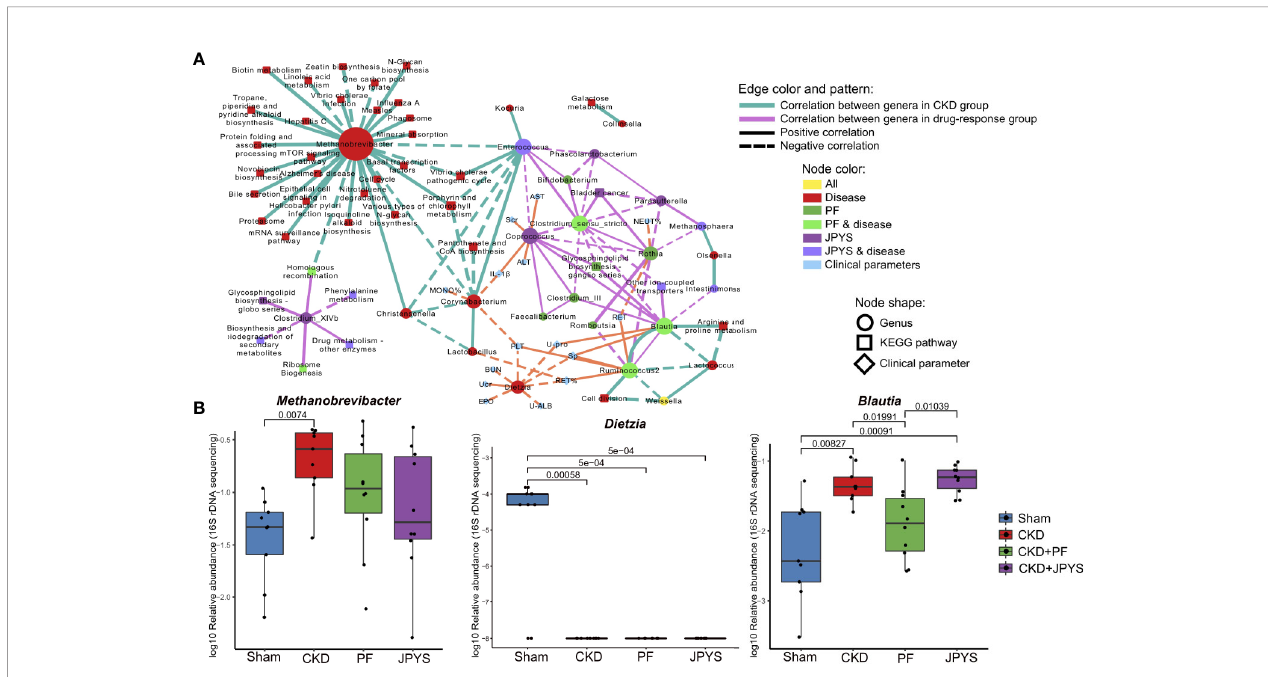
FIGURE 3 | Gut microbiome markers correlated with host clinical outcomes. (A) Correlation network of microbiome marker, clinical parameter, and KEGG pathway. Circles represent markers of genus; Squares represent KEGG pathways; and diamonds represent clinical parameters. Node colors indicate treatment groups. Node sizes are scaled according to their degrees of connections. The larger the node is, the more connections it has. Two nodes are connected if their spearman correlation is signi fi cant ( p < 0.05, FDR-corrected) between genera, or between genera and KEGG pathways. Connections are drawn between genera and clinical parameters only when their spearman correlation is signi fi cant ( p < 0.05, FDR-corrected) and the absolute of correlation coef fi cient is larger than 0.6. Thickness of edges between nodes is scaled according the absolute value of spearman correlation coef fi cient. Edge colors indicate correlations between genera (or between genera and KEGG pathways) in different groups (green: CKD group; pink: treat groups of PF and JPYS). Orange edges represent correlations between genera and clinical parameters. Dotted and solid lines indicate negative or positive correlations respectively. (B) Relative abundances of keystone genus-level microbiome markers in each group. Keystone markers are manually selected from the network hubs, with regard to their interspecies interactions and clinical associations. Variations between groups were tested by Wilcoxon rank-sum test with FDR correction. Only signi fi cant differences between groups ( p < 0.05) were annotated. FDR, false discovery rate; JPYS, Jian-Pi-Yi-Shen decoction; PF, Piperazine ferulate; CKD, chronic kidney